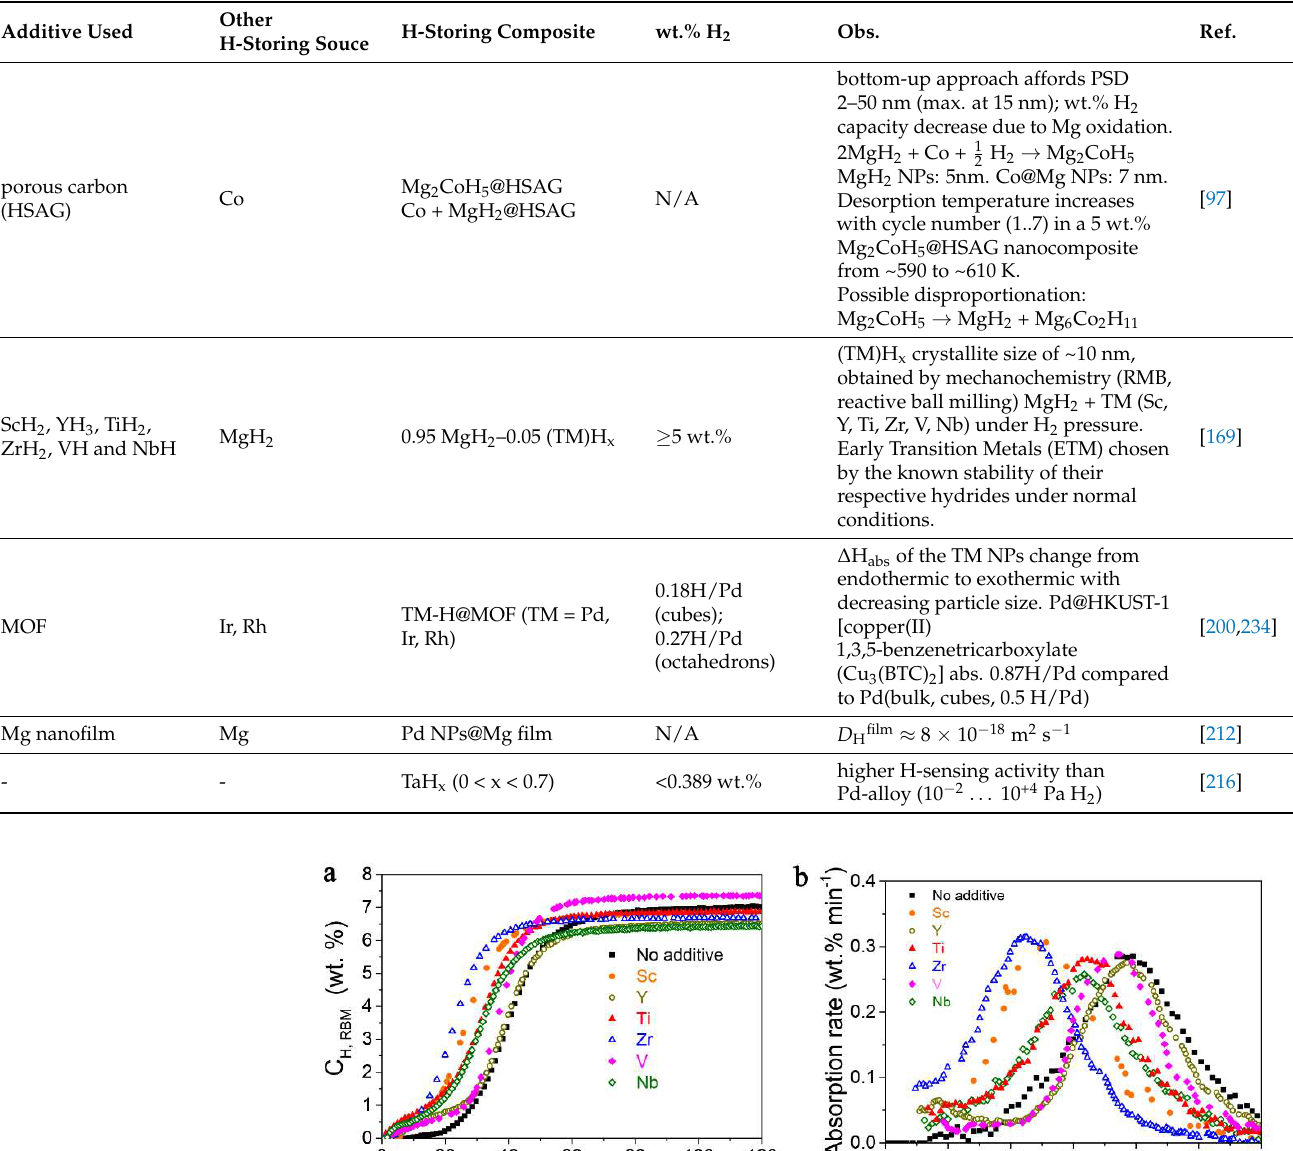
Table 13. Hydrogen storage features of nanosized (TM) H x materials.